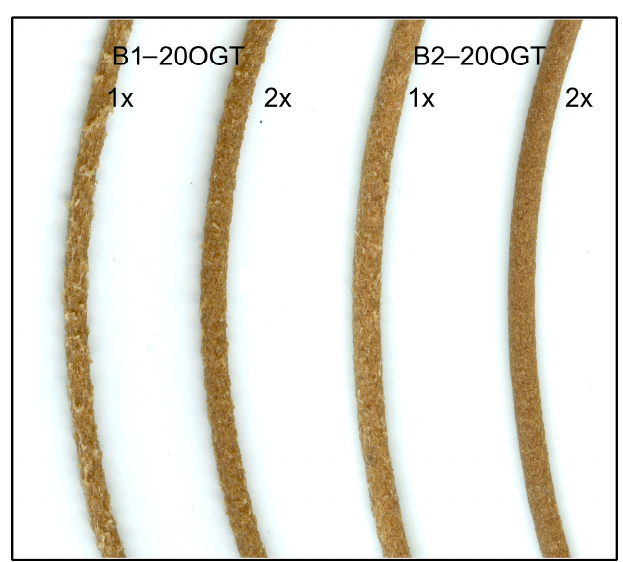
Figure 2. Representative filaments after first (1×) and second (2×) extrusion.